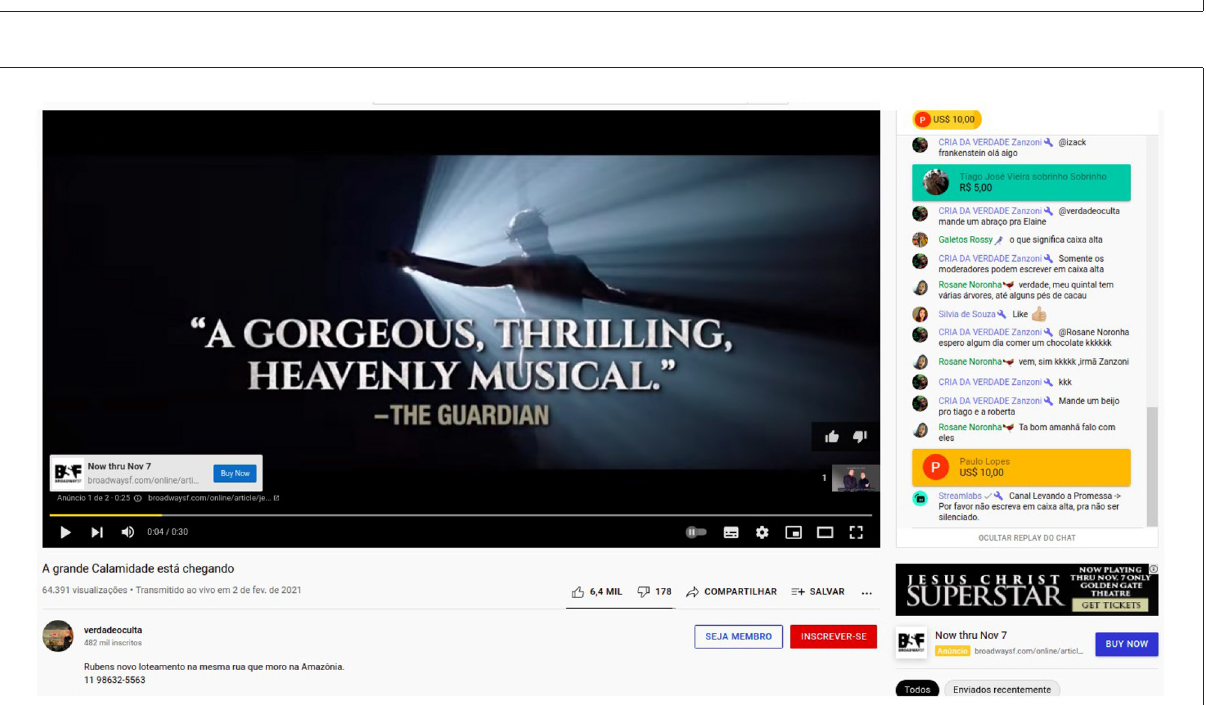
FIGURE3 Screenshot of a video from the channel Verdade Oculta streamed in February 2021 and still monetized by YouTube. The video affirms that the COVID-19 pandemic is part of a conspiracy and describes the channels’ project to save Brazilians from depopulation. The video description announces the opportunity to buy land near the content creator